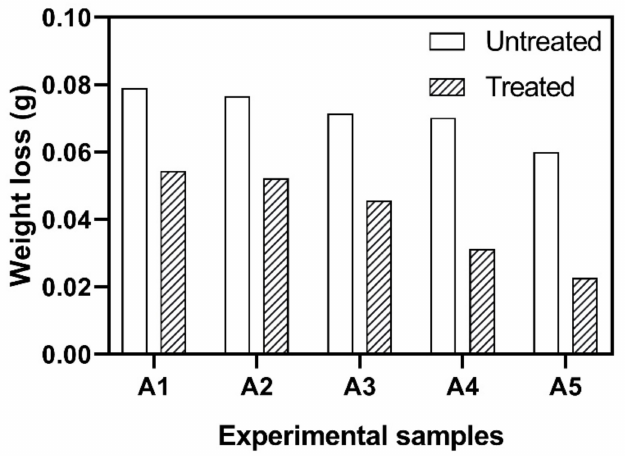
Figure 14. Mass loss of samples.